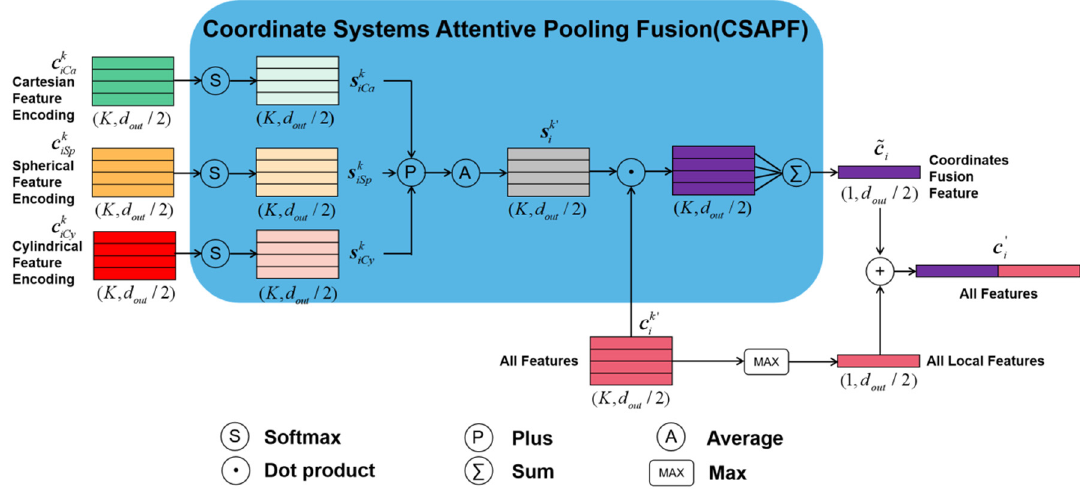
Figure 6. The structure of CSAPF block.